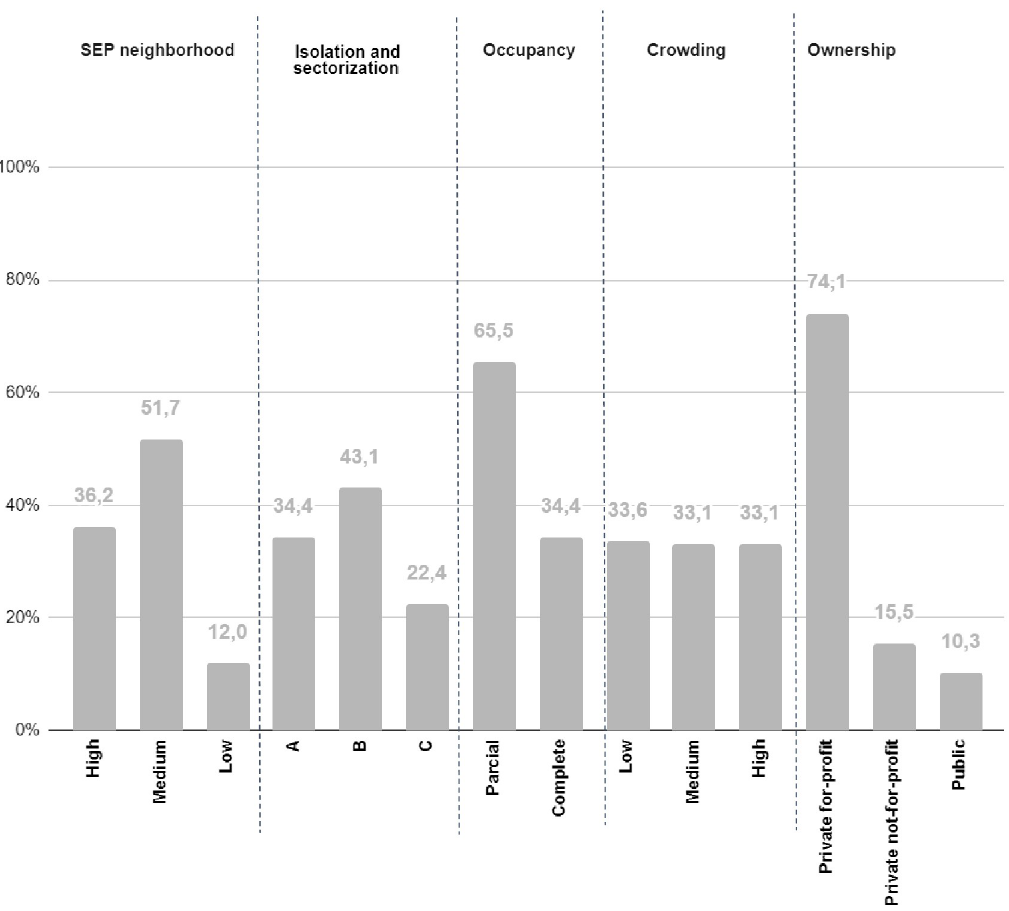
Fig 2. Characteristics of the NHs. Description of the characteristics of the NHs of the city of Barcelona in the period March- June 2020.